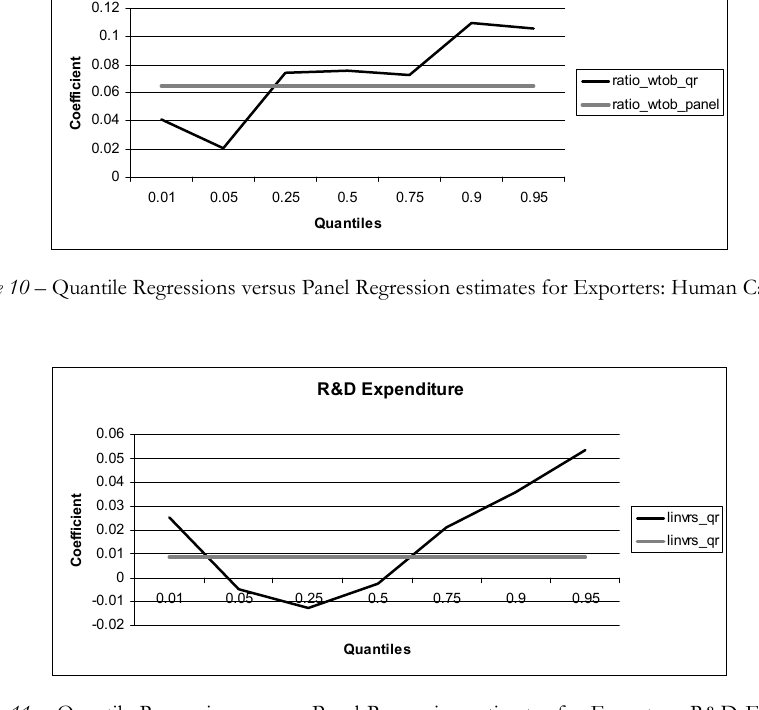
Figure 11 – Quantile Regressions versus Panel Regression estimates for Exporters: R&D Expendi-